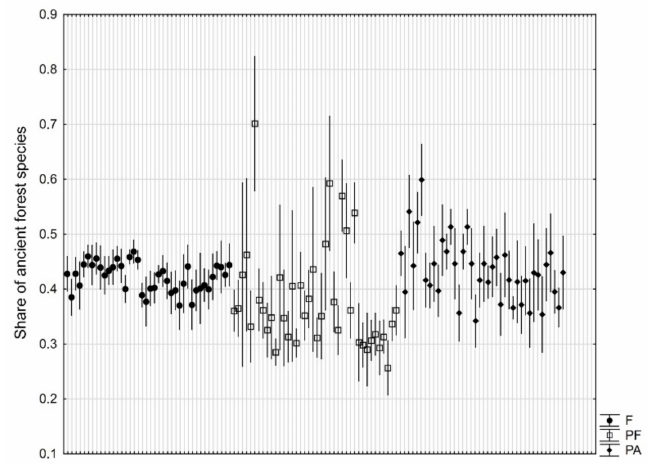
Figure 4. Share (mean ± 95% confidence interval based on 10 research plots of 100 m 2 ) of ancient forest species in natural forests (F), manor parks adjacent to forests (PF), and manor parks not adjacent to forests (PA).